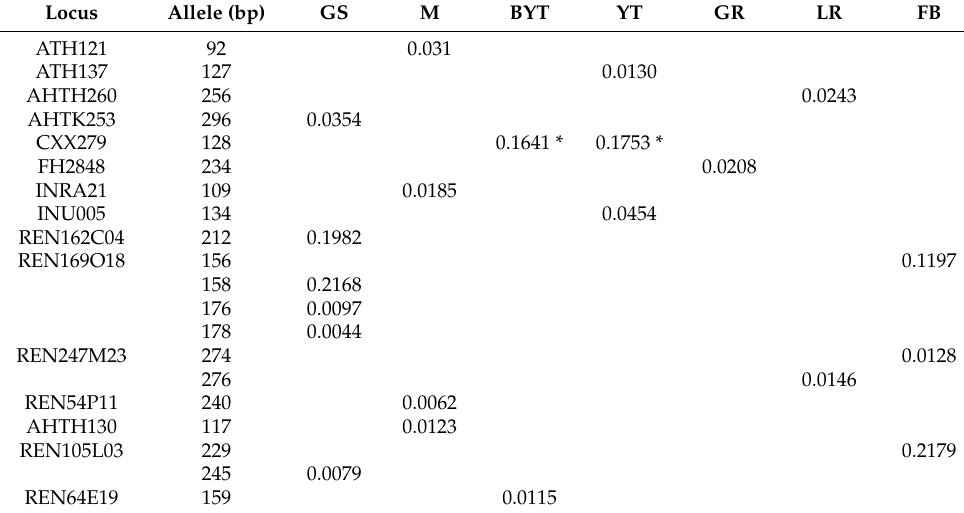
Table 3. Frequency of private alleles in the study breeds.